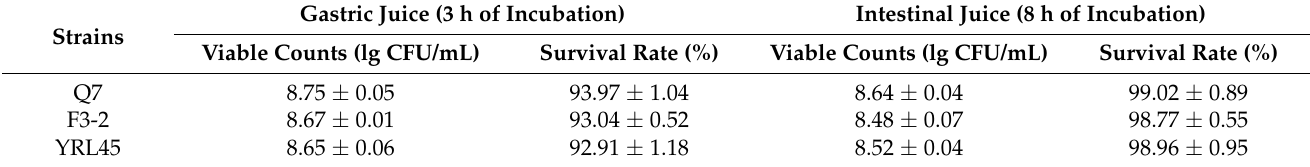
Table 5. Gastric and intestinal juice tolerance of L. plantarum Q7, L. plantarum F3-2 and L. plantarum